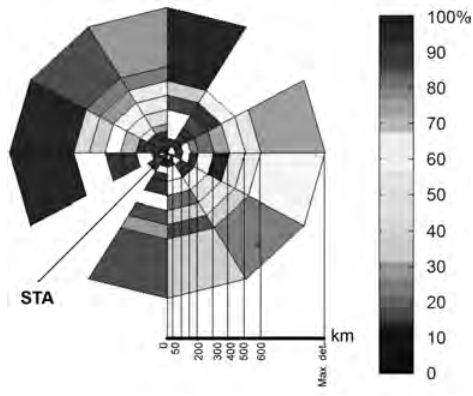
Fig. 14. Criteria to determine the detection capacity of the seismographic stations. The area around each station has been divided in twelve parts (30° each), ea- ch part has been divided in to sectors whose dimen- sions are related to the distance from the station: for the first 200 km the sectors are 50 km by 50 km, from 200 km to 600 km the distances are 100 km each. The farthest sector has the distance, from the station, deter- mined by the farthest event detected (marked in the fi- gure by a red or white star). The white sectors, even- tually not closed, indicate a lack of